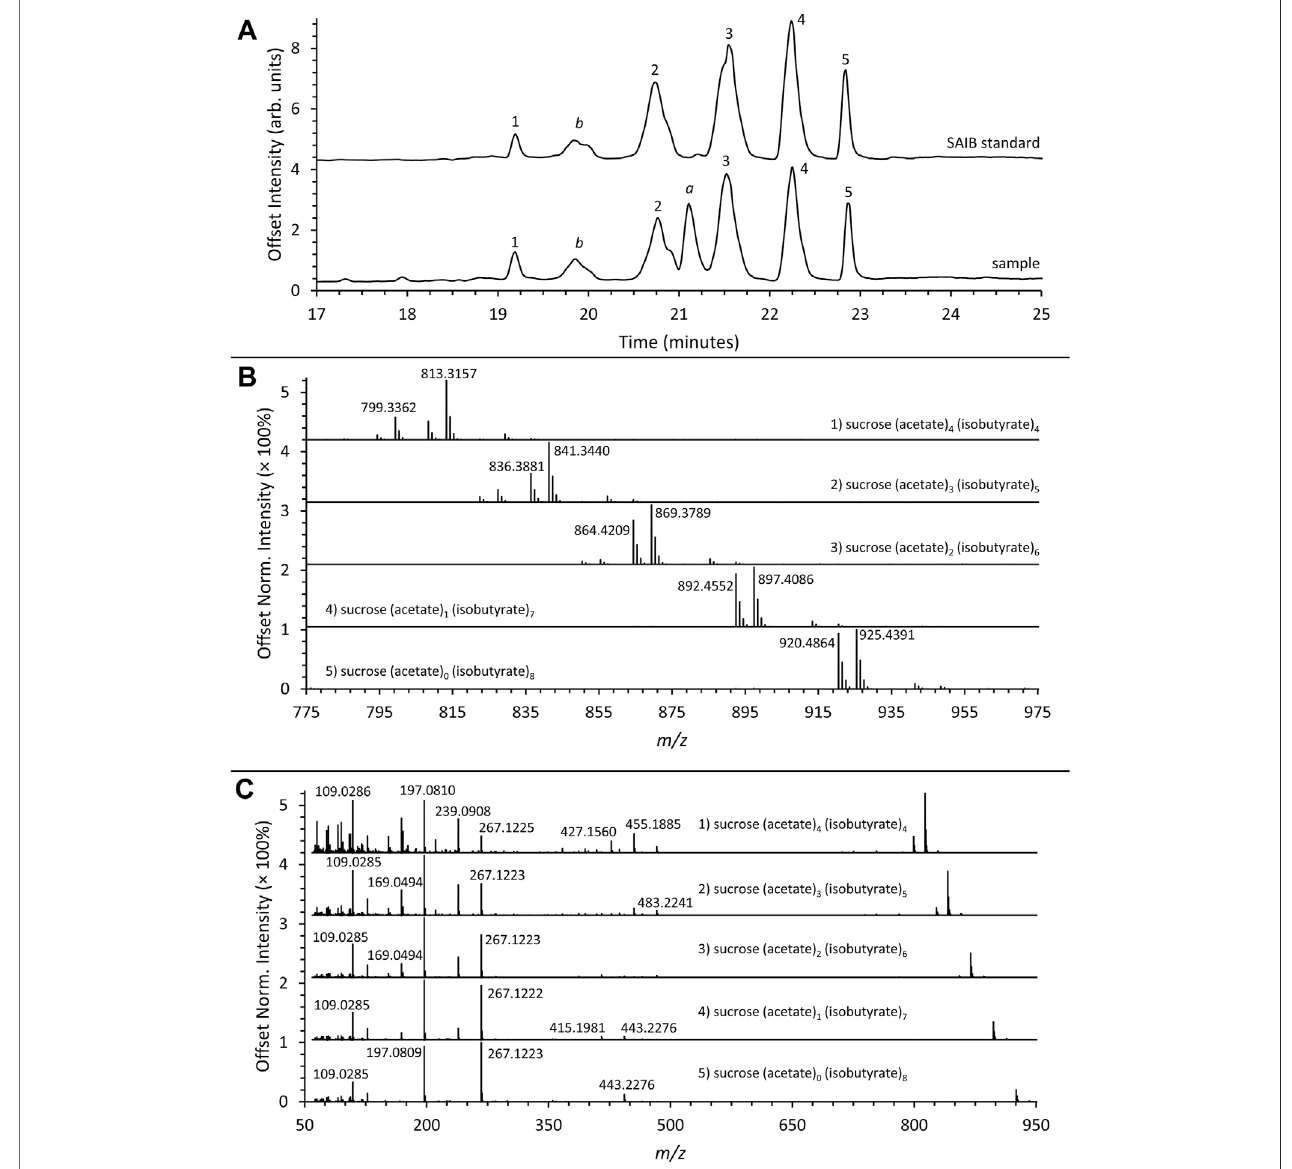
FIGURE 8 | (A) LC-HRMS total ion chromatograms of the SAIB reference standard (top) and sample (bottom) showing a series of fi ve SAIB peaks (peak labels 1 – 5). Peak a corresponds to d9THC and peak b corresponds to a background impurity also present in blanks. (B) Mass spectra corresponding to the fi ve SAIB chromatographic peaks. (C) AIF spectra corresponding to the fi ve SAIB chromatographic peaks.